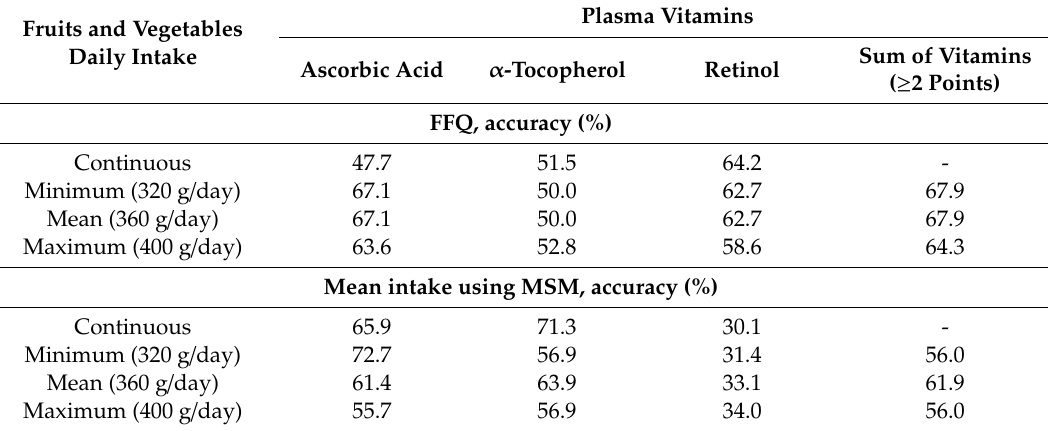
Table 3. Percentage of accuracy from receiver operating characteristics (ROC) curve of fruits and vegetables daily intake estimated by FFQ and by MSM according to the type of plasma vitamin. S ã o Paulo, Brazil.